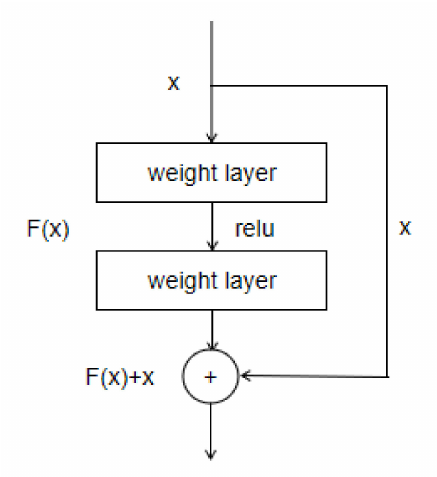
Figure 5. Basic network structure of the ResNet101 convolutional neural network.